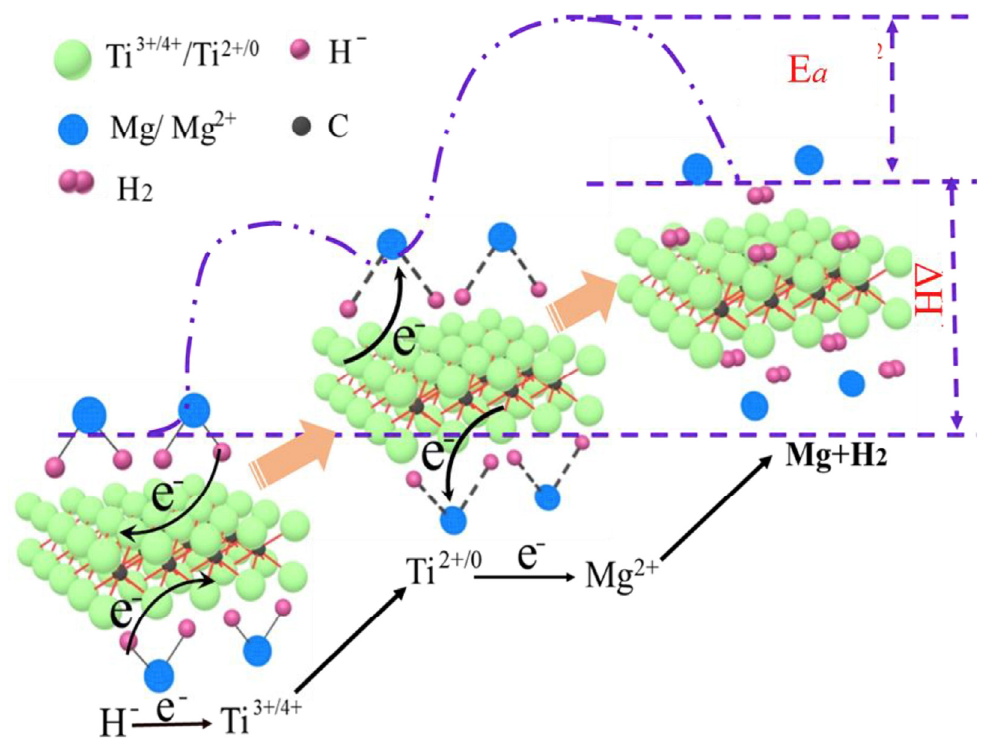
Figure 11. Schematic of the mechanism of Ti 2 C in catalyzing the dehydrogenation of MgH 2 . Copy- right 2019, Elsevier. Reproduced with permission from [115].